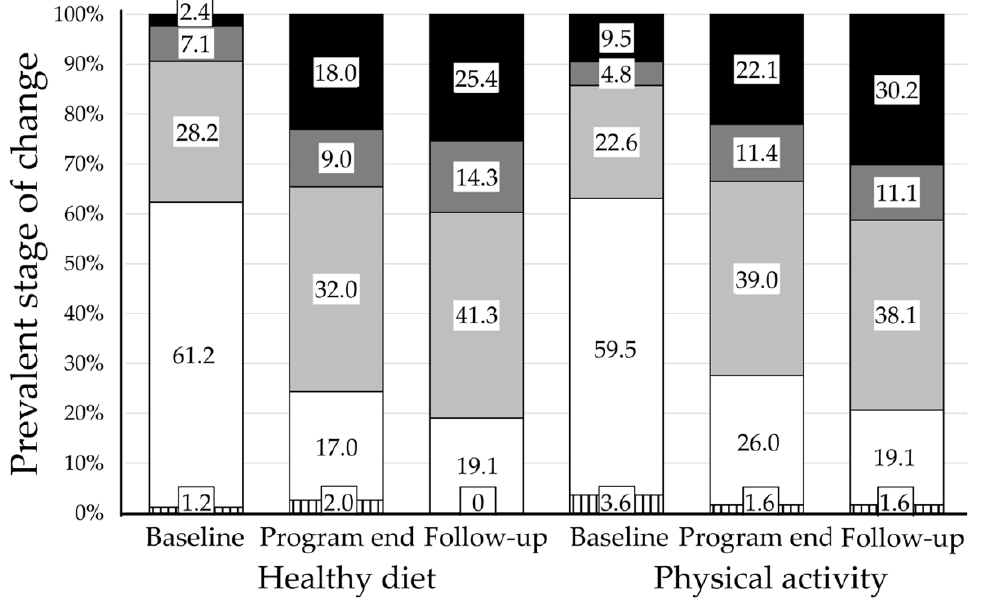
Figure 2. Prevalent stage of change at baseline and during the whole study period. The analysis covers the patients at enrollment ( n = 86), at the end of the motivational interviewing (MI) program ( n = 73) and at 6-month follow-up ( n = 65). Note the progressive shift from the contemplation stage to determination, action and maintenance.